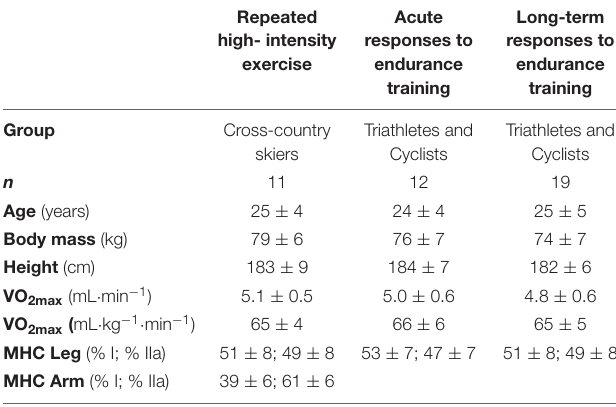
TABLE 1 | Subject